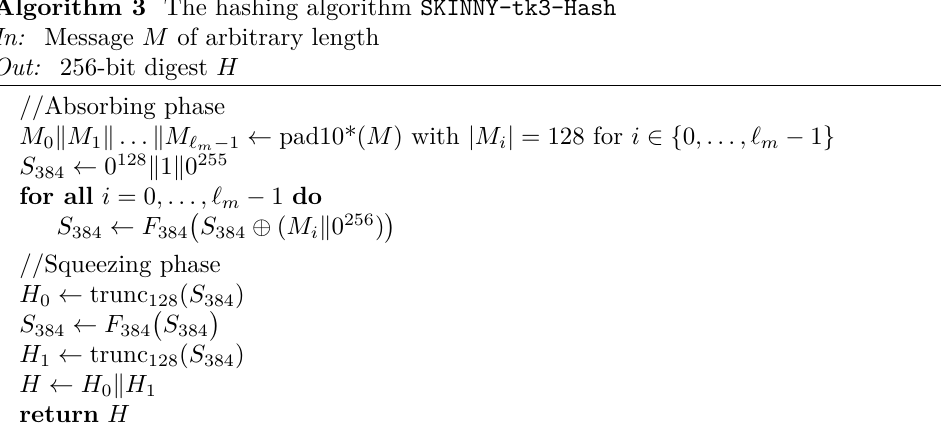
Figure 6: Construction of the functions F 256 and F 384 used in SKINNY-tk2-Hash and SKINNY-tk3-Hash , respectively. Algorithm 3 The hashing algorithm SKINNY-tk3-Hash